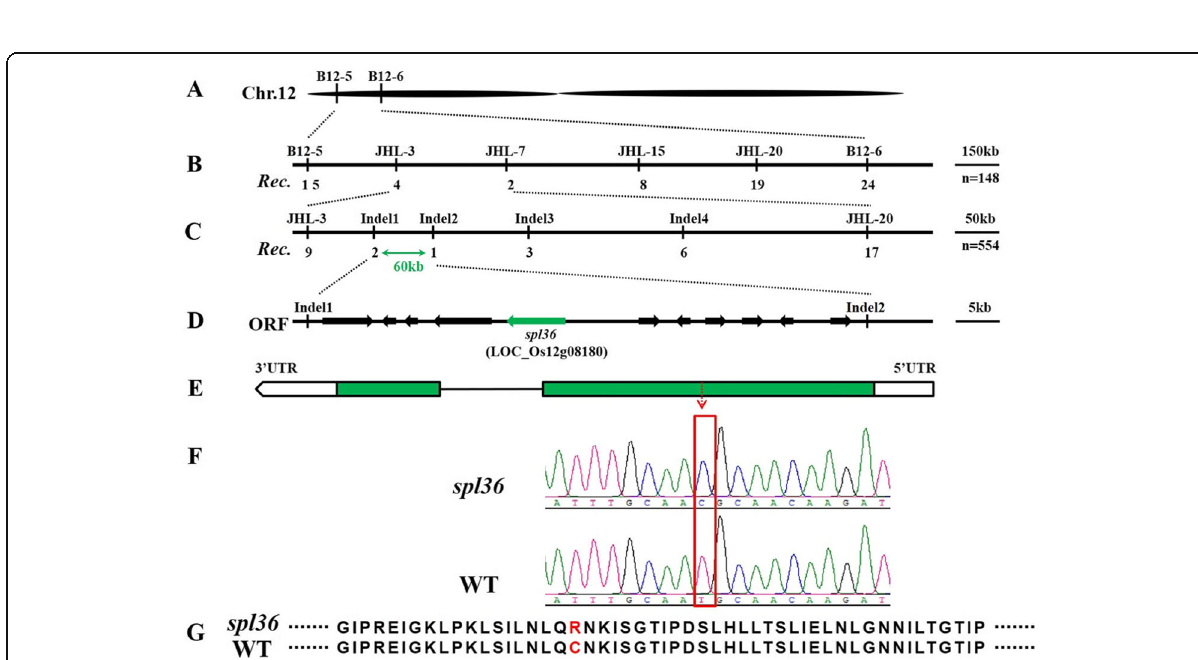
Fig. 5 Genetic and physical maps of the SPL36 gene. a The SPL36 gene was localized to chromosome 12 between InDel markers B12 – 5 and B12 – 6. b The SPL36 gene was delimited to the JHL-3 to JHL-7 interval on chromosome 12 using 148 F 2 mutant individuals; marker names and number of recombinants ( Rec. ) are shown. C Fine genetic mapping of the SPL36 gene based on 554 mutant F 2 individuals. d 11 putative ORFs located in the ~ 60-kb region of this locus. e Gene structure of LOC_Os12g08180 . f Sequence analysis of the T-to-C mutation site in wild type and spl36 . g The mutation results in a change from cysteine to arginine in the encoded